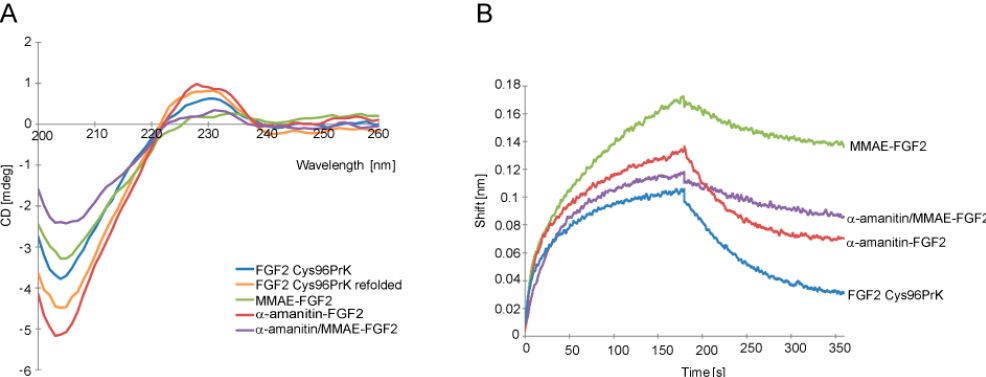
Figure 2. Evaluation of the secondary structure of FGF2 in conjugates and its interaction with fibroblast growth factor receptor 1 (FGFR1). ( A ) Circular dichroism (CD) spectra of native FGF2 Cys96Prk, FGF2 Cys96Prk treated with SDS as in conjugation reaction and subsequently refolded, and purified FGF2 single- and double-conjugates; ( B ) Bio-Layer Interferometry plots show binding analysis of conjugates to extracellular domain of FGFR1 (FGFR1_ECD) chemically immobilized on Amine Reactive Second-Generation biosensor (ARG2). Signal was corrected for sensor chip without immobilized FGFR1.